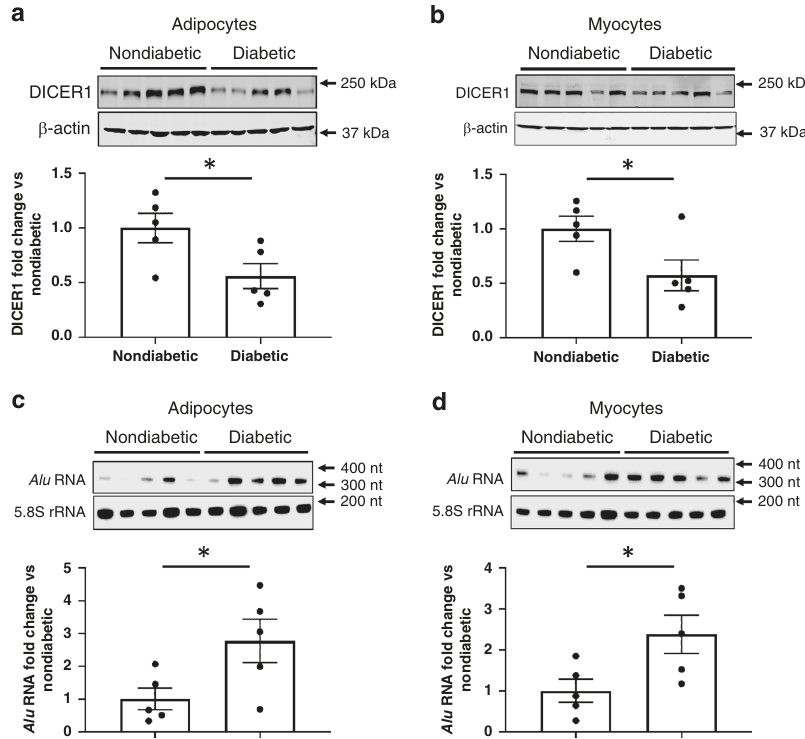
Fig. 3 Expression of DICER1 and Alu in human diabetic adipocytes and skeletal myocytes. The top panels show the results of western blotting of extracts of proteins from human adipocytes a and human myocytes b isolated from nondiabetic and diabetic persons. Immunoreactive bands corresponding to DICER1 and beta-actin ( β -actin) are shown. The bottom panels show bar graphs of the densitometric analyses of the DICER1 western blots in the top panels that have been normalized to β -actin abundance and to the nondiabetic group data. * P = 0.04 (diabetic versus nondiabetic adipocytes), * P = 0.046 (diabetic versus nondiabetic myocytes), two-tailed unpaired Student t test. The top panels show the results of northern blotting of total RNA extracts from human adipocytes c and human myocytes d isolated from nondiabetic and diabetic persons. Hybridization bands corresponding to Alu RNA and 5.8S ribosomal RNA (5.8S rRNA) are shown. The bottom panels show bar graphs of the densitometric analyses of the Alu northern blots in the top panels that have been normalized to 5.8S rRNA abundance and to the nondiabetic group data. * P = 0.04 (diabetic versus nondiabetic adipocytes), * P = 0.03 (diabetic versus nondiabetic myocytes), two-tailed unpaired Student t test. Data are reported as mean ± s.e.m. n = 5 samples per group a – d . Source data are provided as a Source Data fi